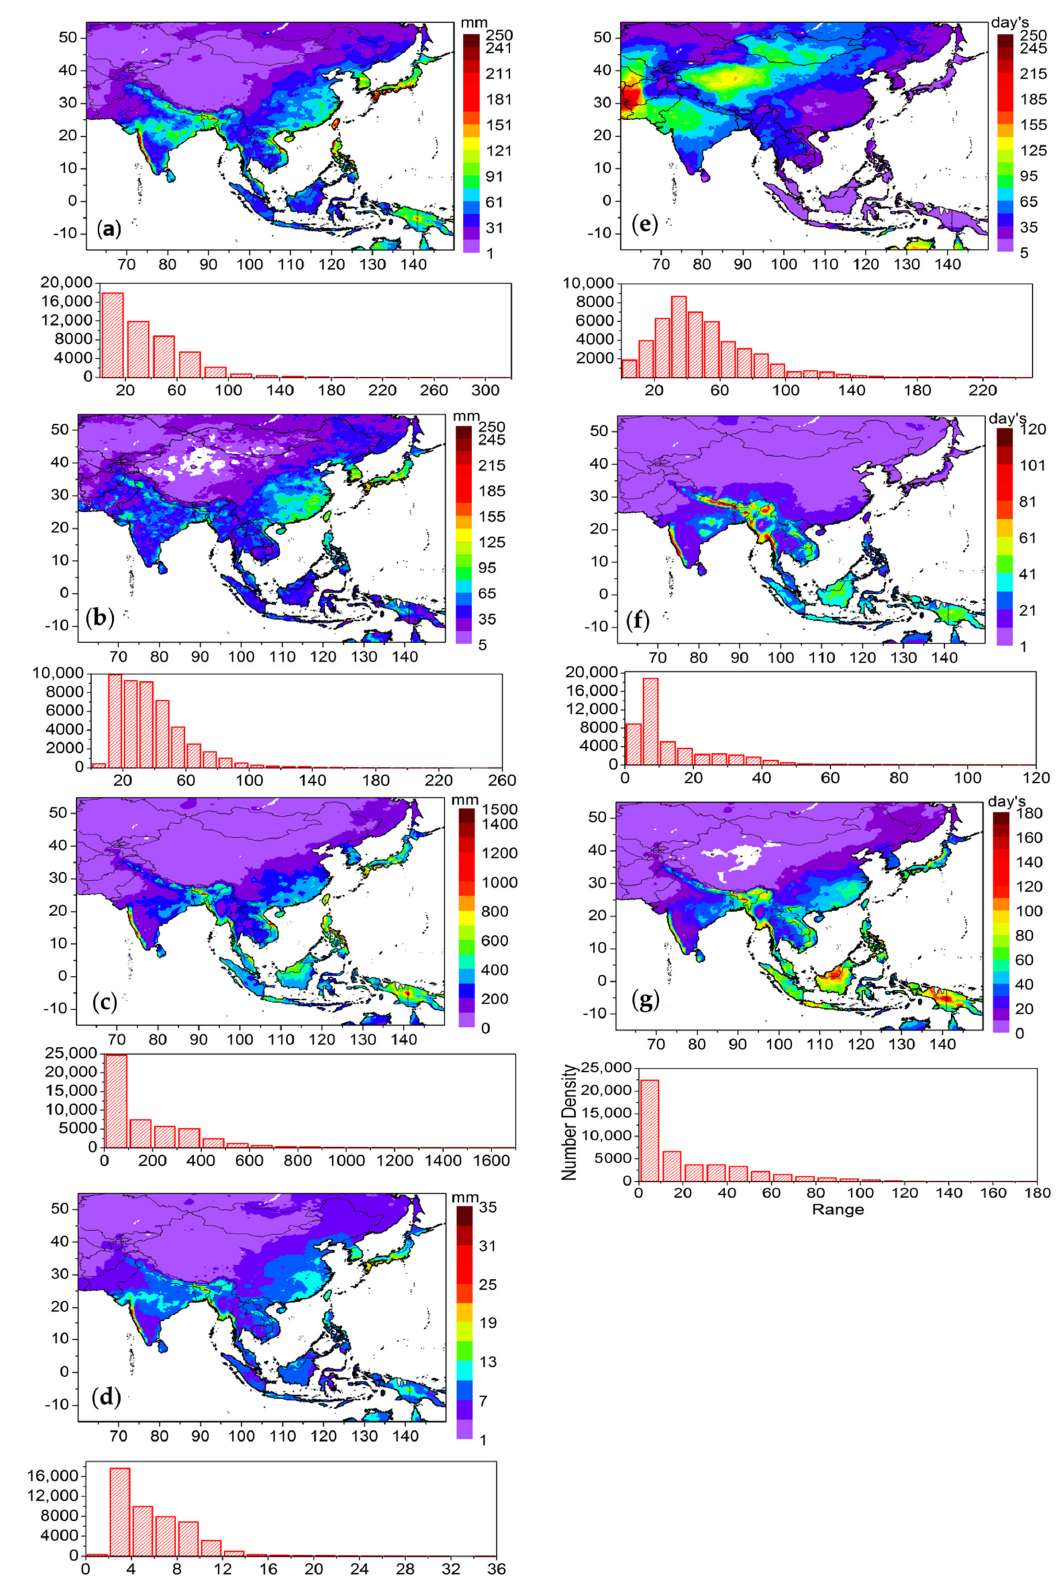
Figure 2. Annual mean spatial variability in precipitation climate change indices ( a ) R × 1 (mm), ( b ) R × 5 (mm), ( c ) R95 (mm), ( d ) SDII (mm/day), ( e ) CDD (days), ( f ) CWD (days), and ( g ) R10 (days) and corresponding histograms that represent bin-wise distribution of precipitation